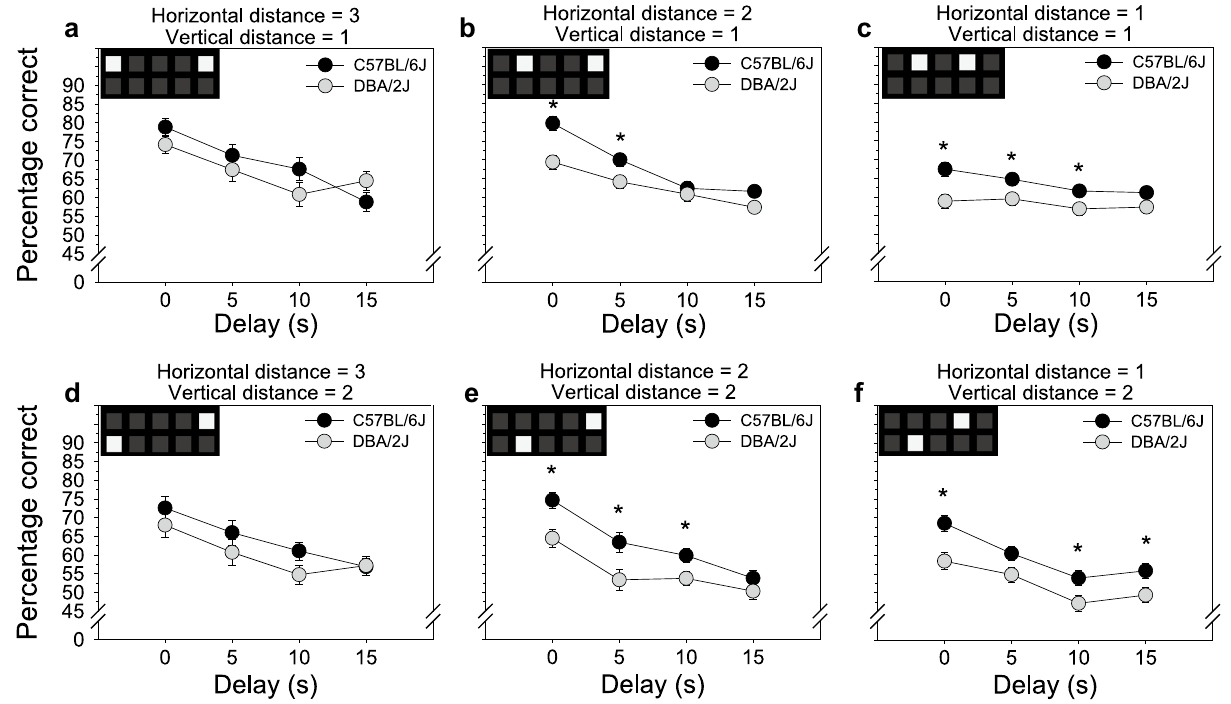
Figure 4. Pattern separation, but not working memory, is significantly impaired in DBA/2J mice relative to C57BL/6J mice 1 . ( a , d ) TUNL performance of C57BL/6J mice and DBA/2J mice was equivalent at all delays when choice-phase stimuli were presented at the widest horizontal distance. (b,c,e,f) In contrast, when choice-phase stimuli were presented at an intermediate horizontal distance and narrow horizontal distance, performance of DBA/2J mice was significantly impaired relative to C57BL/6J mice. This performance impairment was observed at multiple delays, most consistently at the 0 s delay when pattern separation but not working memory would be expected to account for performance variation. This horizontal separation deficit was observed irrespective of vertical distance between choice-phase stimuli (compare top row panels vs bottom row panels). Error bars represent SEM. * p < .05. 1 Stimuli in the top left of each panel represent one example of a choice-phase stimuli configuration within the horizontal and vertical distance category combination. There were multiple possible stimuli configurations within each category combination, and all configurations were used in the TUNL